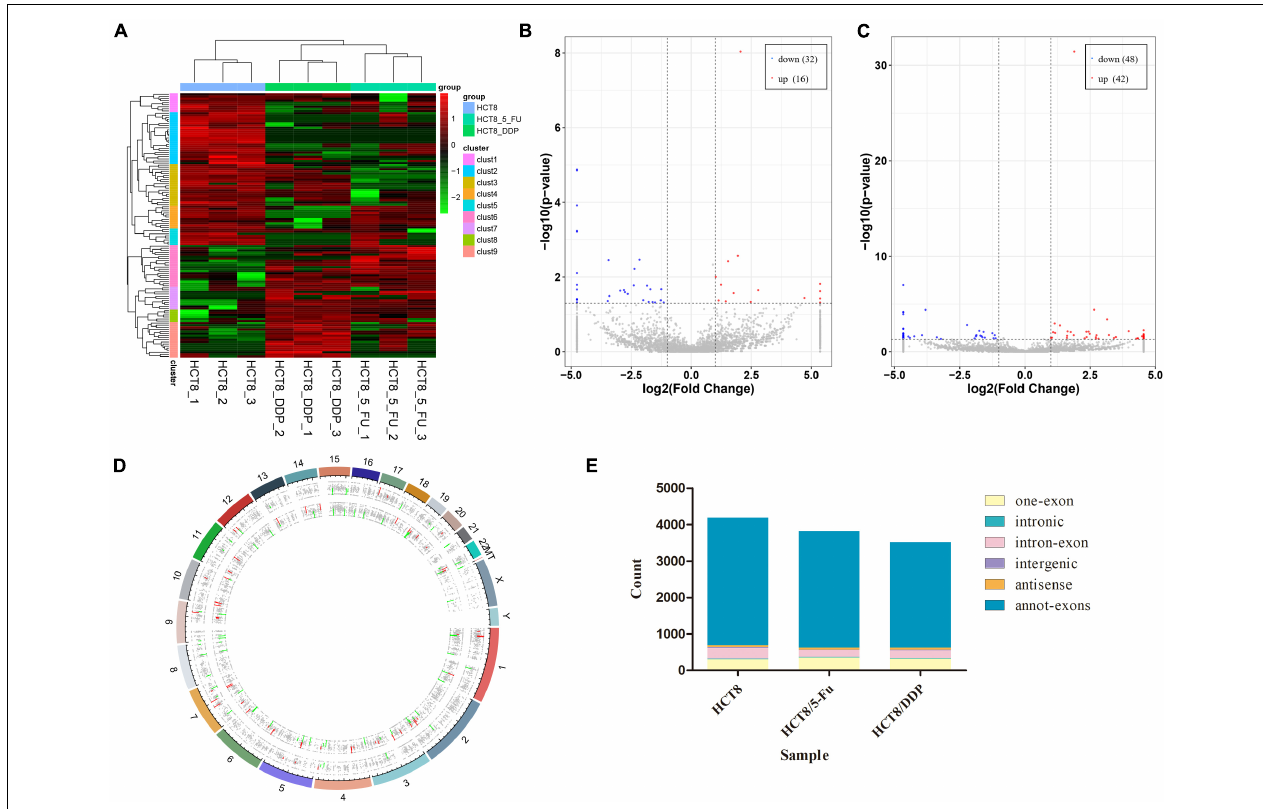
FIGURE 2 | Expression profiles of circRNAs. (A) Cluster analysis of DE-circRNAs. The volcano plot of DE-circRNAs in (B) HCT8/5-Fu cell lines and (C) HCT8/DDP cell lines. Red denotes increased expression, and blue indicates decreased expression. (D) Distribution of circRNAs on different chromosomes. (E) Genomic origin of the identified circRNAs.